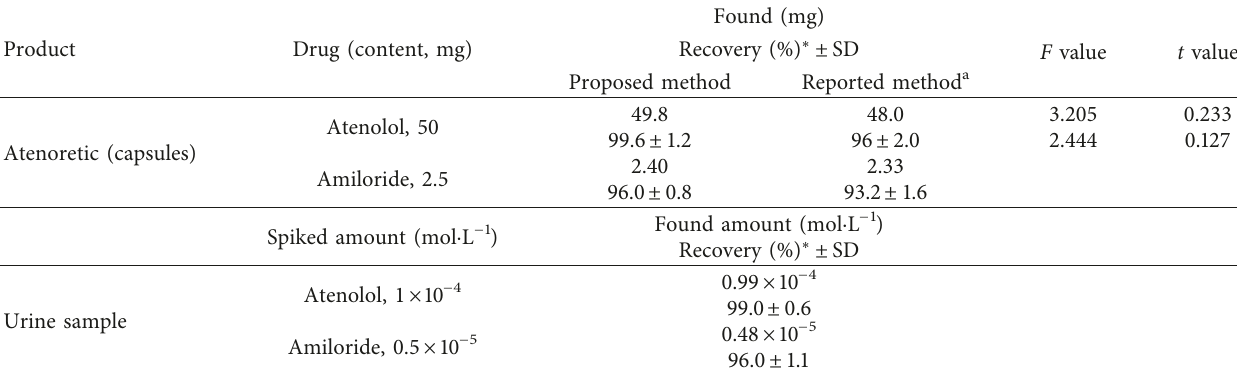
Atenoretic (capsules)